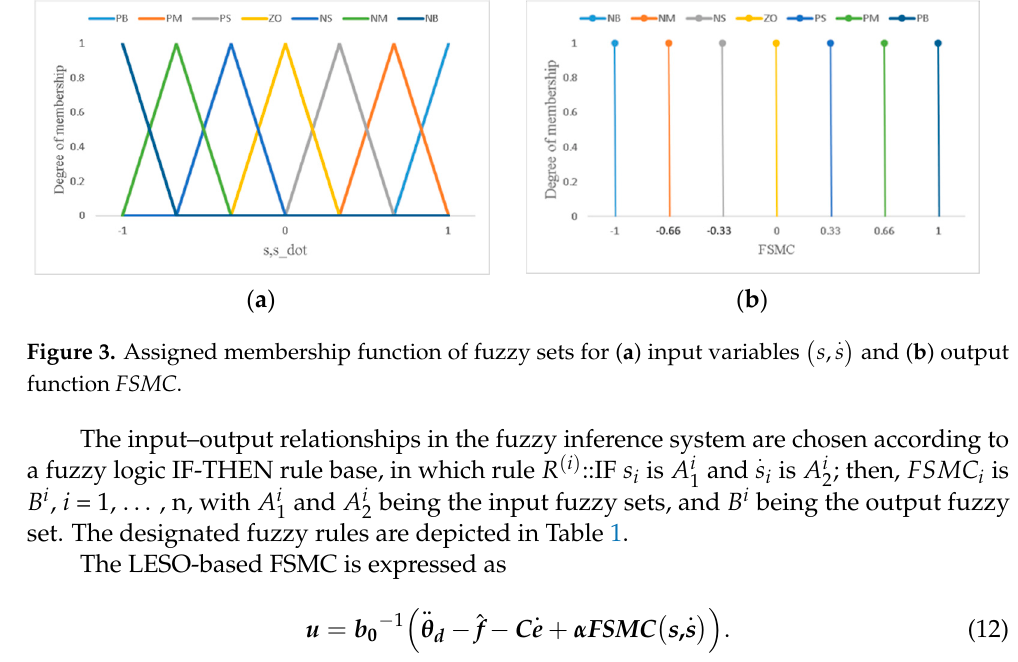
Table 1. Fuzzy rules for FSMC.